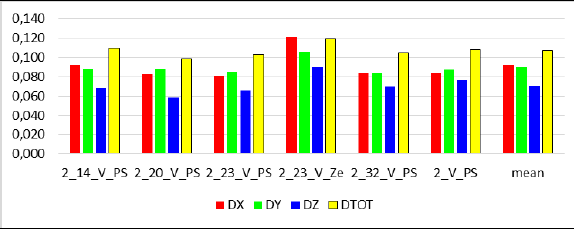
Figure 18. X, Y, Z, 3D distances of various DPC from